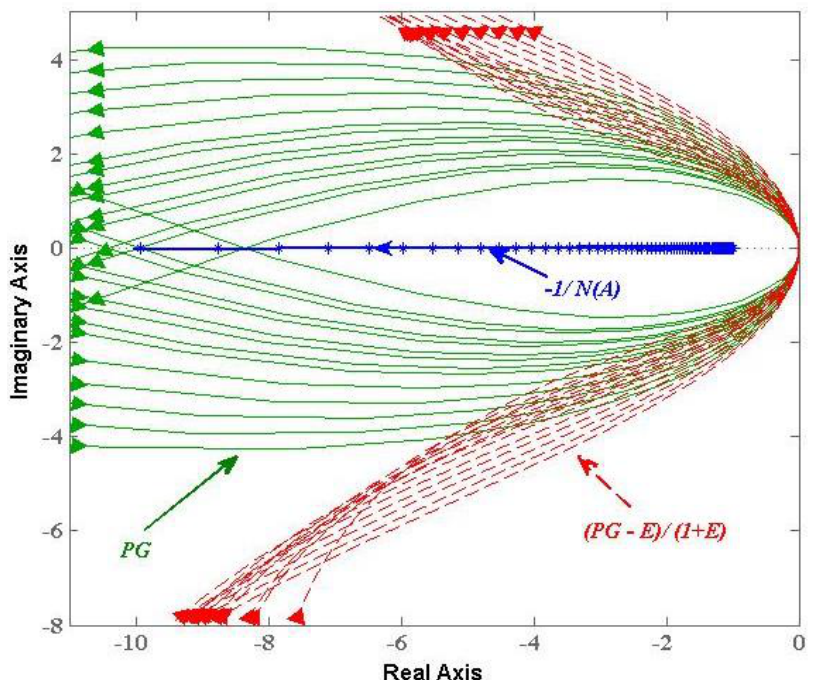
( PG − E ) for ( 1 + E ) for (1 + 𝐸) for (1 + 𝐸)